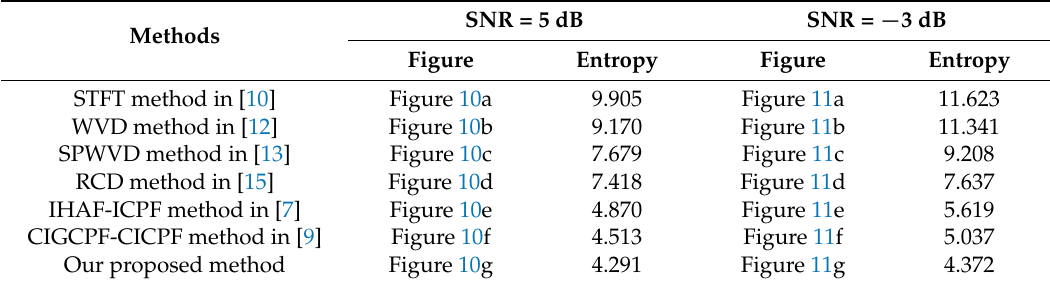
Table 2. Entropies of ISAR Images in Figure 10 and Figure